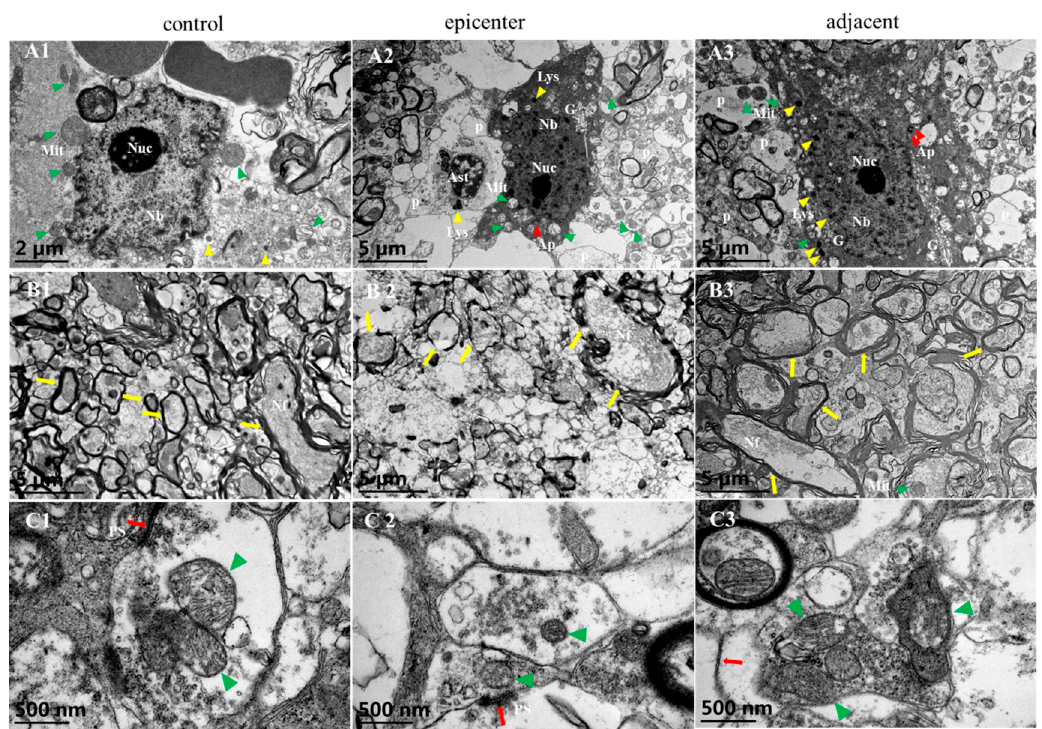
Figure 4. Ultrastructural evidence of neuronal degeneration and axonal demyelination. Large motoneuron and its axon with axonal terminal in control group ( A1 , B1 , C1 ), compressive epicenter ( A2 , B2 , C2 ) and adjacent level ( A3 , B3 , C3 ). ( A1 ) Even distribution of Nissl body (Nb) in nucleus (Nuc), abundance of mitochondria (Mit) with distinguished cristae and several process (P). ( B1 ) Clearly identified structure of the myelin and axon. ( C1 ) Synapse and its mitochondria and post synapse (PS). ( A2 ) Increased lysosome (Lys), autophagosome (Ap) and disappearance of mitochondrial cristae implied neuronal degeneration and death. ( B2 ) Thinner layer of myelin and disorganization or destruction of axon. ( C2 ) Abnormal synapse with blurred mitochondrial cristae and loss of synaptic vesicle. ( A3 ) Amelioration change of neuron in adjacent level. ( B3 ) Thicker myelin sheath but with disorganized myelin laminae and neurofilament (Nf). ( C3 ) Similar appearance of synapse as that in the control group but with increased and aggregated synaptic vesicles.